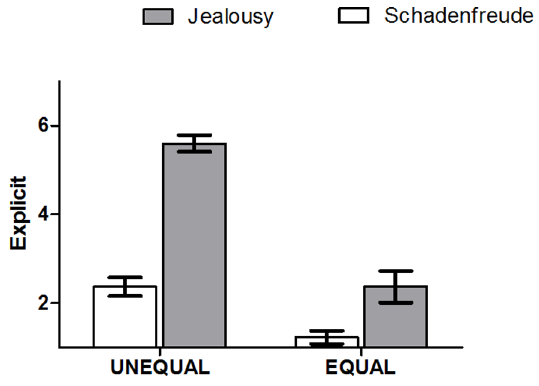
Figure 2. Explicitness: Hierarchical jealousy and schadenfreude scales. A significant main effects of the factors phase,condition and phase*condition . F ollow-up paired t tests indicate that the difference between the UNEQUAL and the EQUAL condition was evident both in phase 1 ratings and in phase 2 ratings.